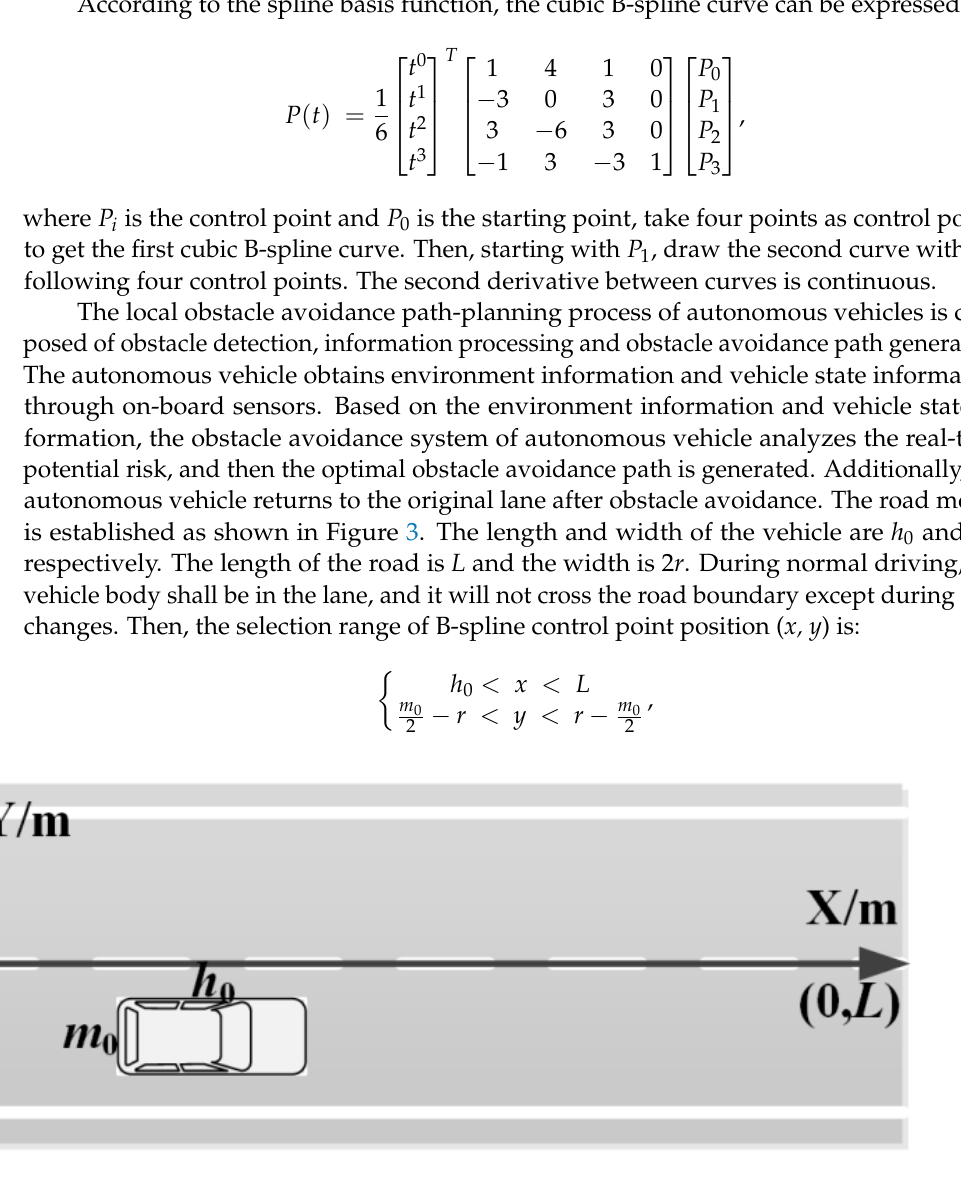
Figure 3. Schematic diagram of road boundary constraint.